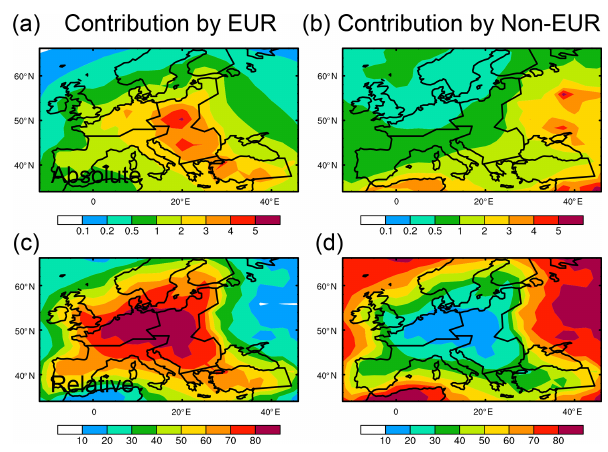
Figure 5. Relative contributions (in percent) by emissions from ma- jor tagged source regions including Europe (EUR), North Amer- ica (NAM), northern Africa (NAF), the Middle East (MDE), East Asia (EAS), Russia–Belarus–Ukraine (RBU), non-Arctic/Antarctic ocean (OCN), and other (OTH) regions to near-surface concentra- tions (a, b, c) and column burdens (d, e, f) of sulfate, BC, and POA (from top to bottom) in the four subregions of Europe, averaged over 2010–2018. Patterned areas represent local EUR